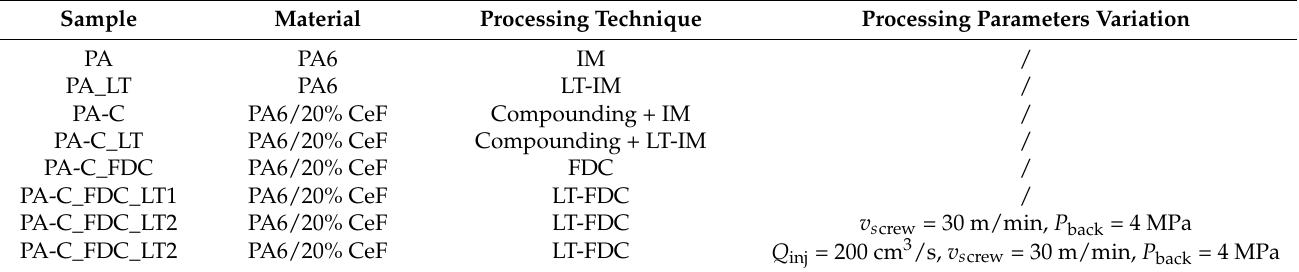
Table 2. Samples composition, processing techniques and processing